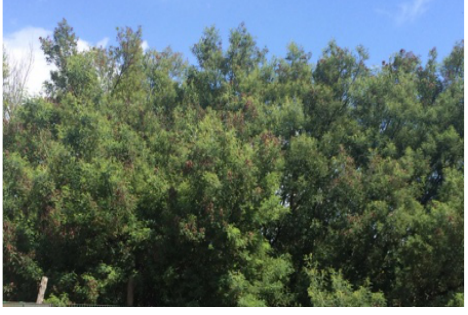
Figure 19. Vegetation obstacle